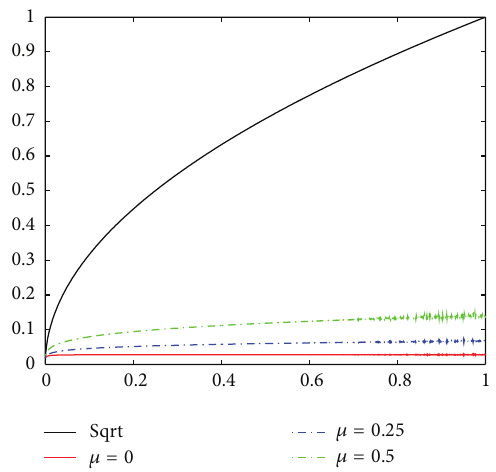
Figure 4: The outcome of the fractional signal when 𝛼 = 0.75, 𝑇 = 1 .